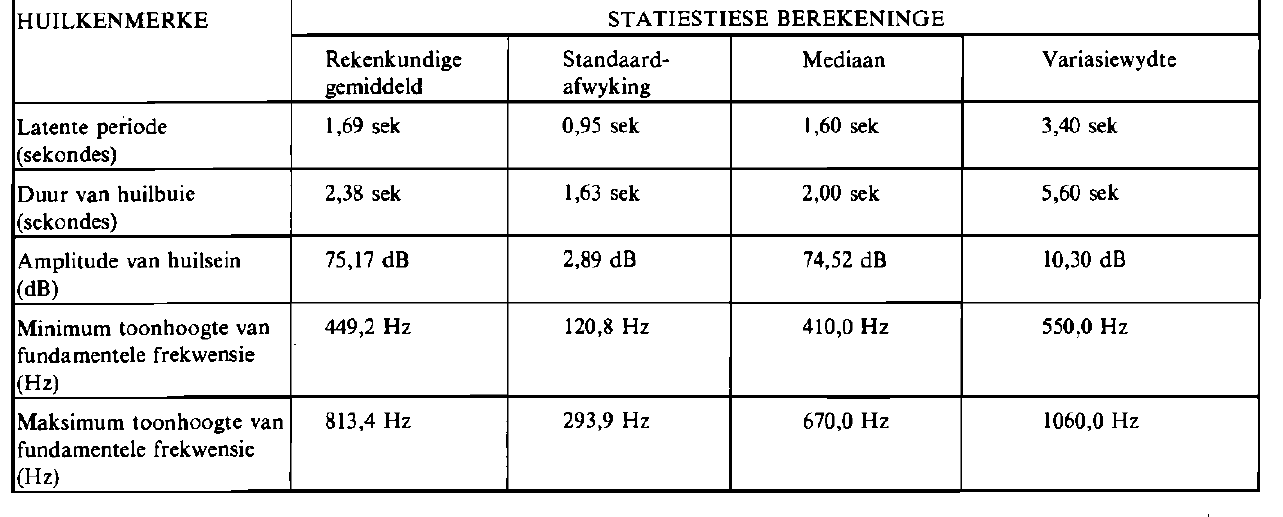
Tabel 9: Data wat van spektrografiese huilanalises van die proefpersone verkry is (n = 25)